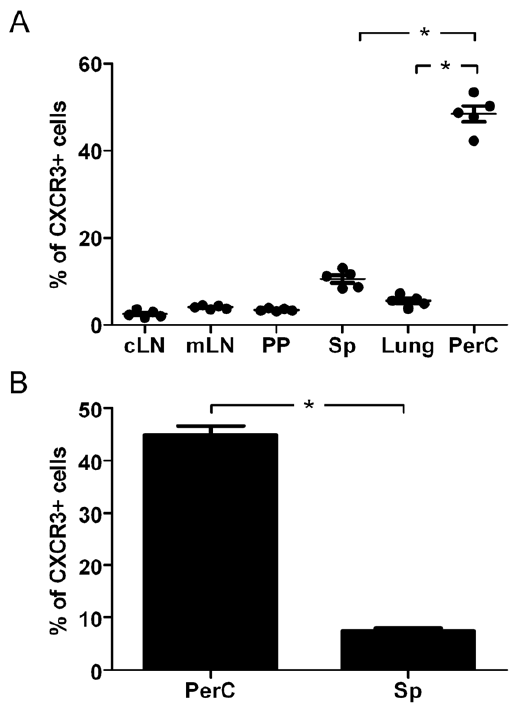
Figure 1. The percentage of CXCR3 + CD4 + T cells is higher in PerC than in other organs. The percentage of CXCR3 + CD4 + T cells in different organs was determined by flow cytometry. (A) Cells isolated from naı¨ve Balb/c animals were analyzed (n=5). Each point represents an individual animal. (B) Cells isolated from 10 to 20 naı¨ve Balb/c animals were pooled. Results from 8 independent experiments are presented. Error bars indicate SEM. cLN, cervical lymph node; mLN, mesenteric lymph node; PP, Peyer’s patches; Sp, spleen; PerC, peritoneal cavity. (*) Statistically significant at P , 0.05. doi:10.1371/journal.pone.0018032.g001 CXCR3 + and CXCR3 2 CD4 + cells from Sp of BALB/c mice and differentially stained them with CFSE and CMTMR, respectively.